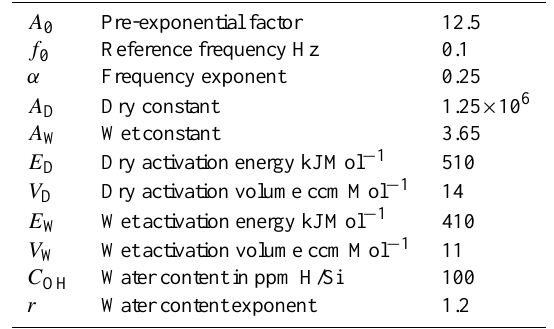
Table 1: List of constants used to compute temperature and pressure dependent values for the inverse quality factor ac- cording to Eq.